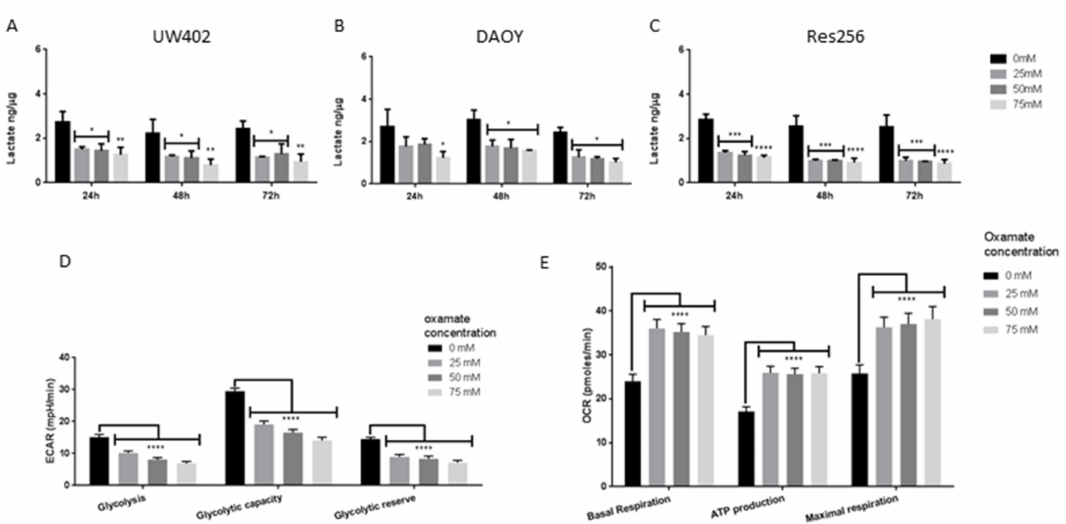
Figure 3. Effects of oxamate on MB metabolism. MB cell lines were grown in the presence of 0 mM, 25 mM, 50 mM or 75 mM oxamate. ( A – C ) Lactate concentrations of lysates prepared from ( A ) UW402, ( B ) DAOY, and ( C ) Res256 cells treated for 24–72 h. Lactate concentrations were normalised to the protein concentrations of each sample. ( D ) ECAR (mpH/min) of UW402 cells treated for 24 h. Glycolysis, glycolytic capacity and glycolytic reserve calculated from changes in ECAR with the addition of glucose, oligomycin and 2-DG. ( E ) Oxygen consumption rate (pmoles/min) of UW402 cells treated for 24 h. Basal respiration, ATP production and maximal respiration calculated from changes in OCR with the addition of oligomycin, FCCP, rotenone and antimycin A. Oxamate-treated samples were compared to the untreated control at each time point. Graphs show mean with SEM, not significant p > 0.05, * p ≤ 0.05, ** p ≤ 0.01, *** p ≤ 0.001, **** p ≤